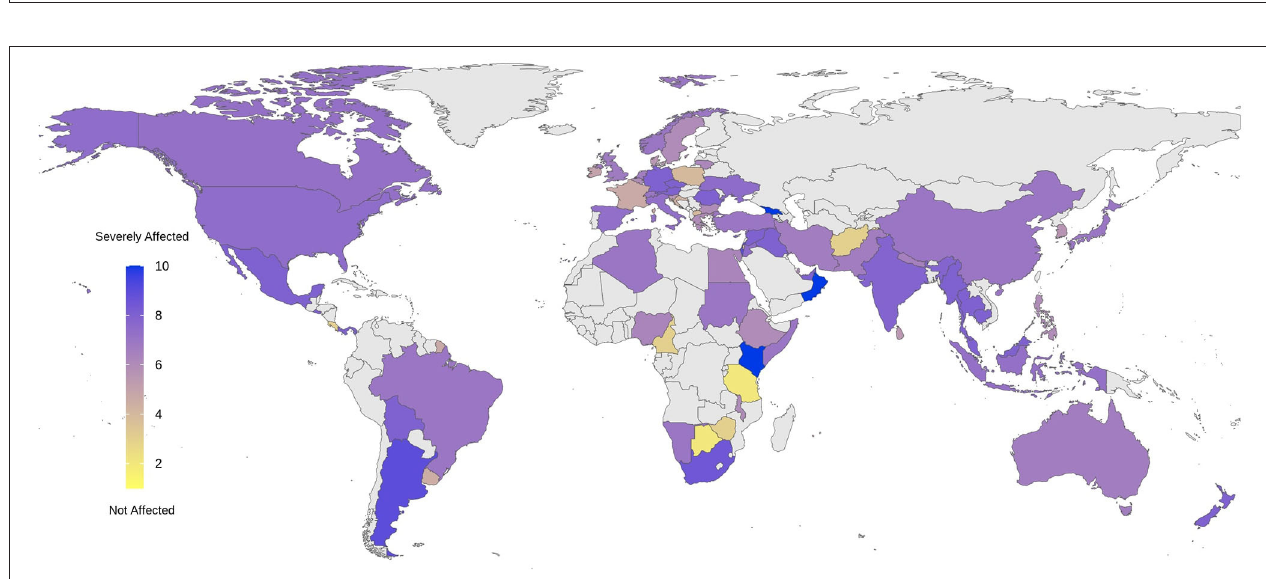
FIGURE 7 | Severity of being affected by COVID-19 outbreak among people with SUDs reported by 177 respondents from 77 countries. Addiction medicine professionals were asked to report how seriously people with SUDs in their countries have been affected by the COVID-19 pandemic using a range of between 1 and 10: 1 representing Not affected , demonstrated with yellow at the beginning of the spectrum, and 10 representing Severely affected at the end of the spectrum, indicated with blue. Responses were collected beginning April 4, 2020 and through a 5-week period.